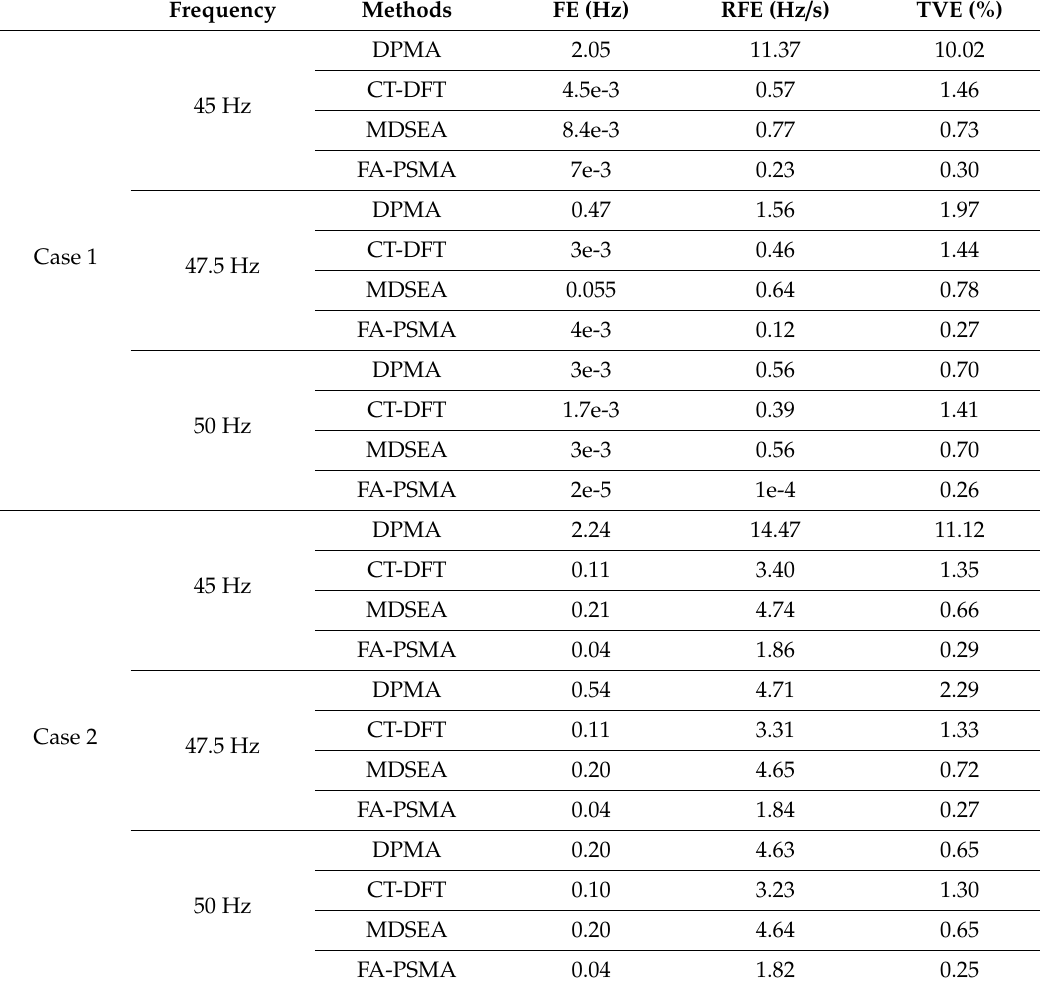
Table 4. Measurement errors of DPMA, CT-DFT, MDSEA, and FA-PSMA under power